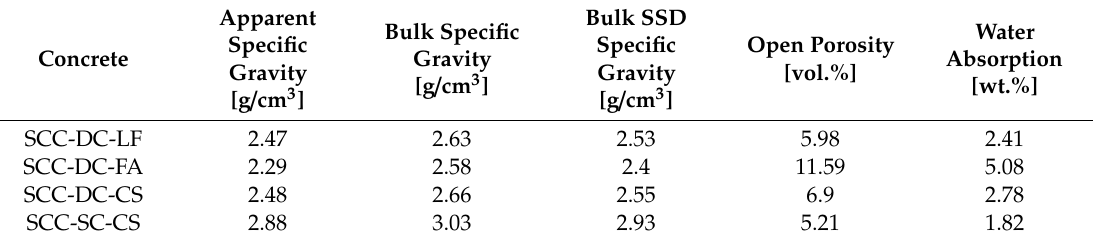
Table 7. Physical properties of the concrete